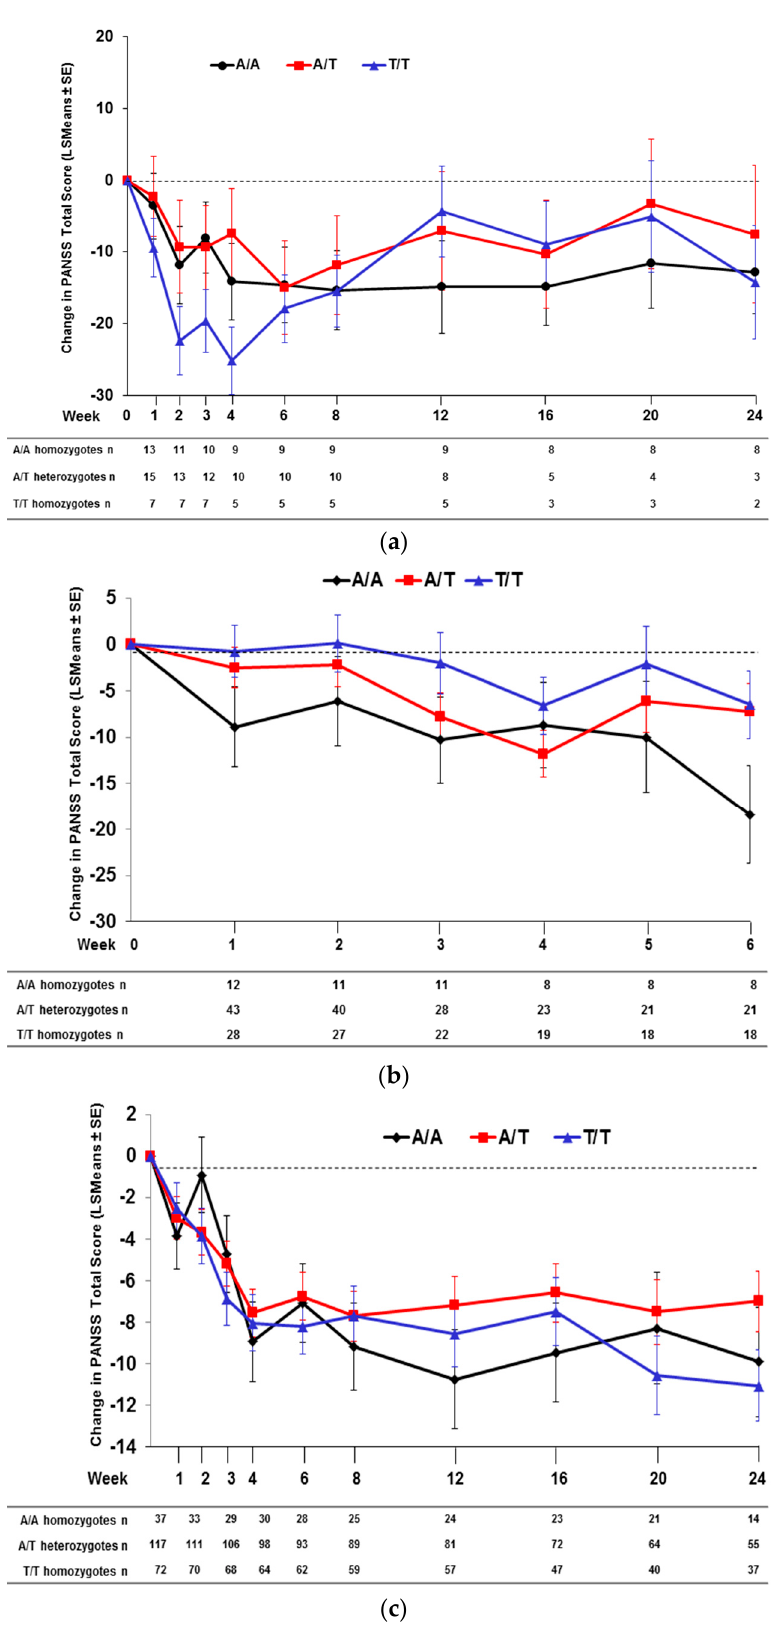
Figure 3. Change in PANSS total score in African American patients treated with pomaglumetad methionil 40 mg BID by HTR2A SNP rs7330461 genotype. ( a ) Study 2. ( b ) Study 3. ( c ) Study 4. Abbreviations: BID = twice daily; n = number of patients with PANSS measures; HTR2A = serotonin 2A receptor ( HTR2A ) gene; LSMeans = least squares means; PANSS = Positive and Negative Syndrome Scale; SE = standard error; SNP = single nucleotide polymorphism.